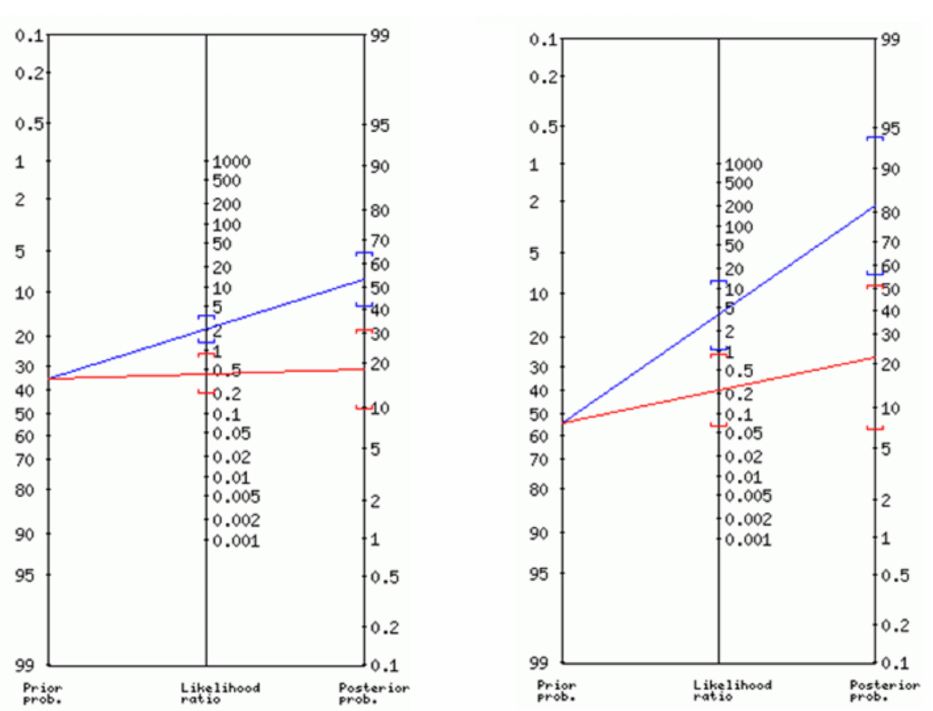
Figure 3. Post-test positive (blue line) and negative (red line) probabilities of malnutrition in can- didates on the waiting list for kidney transplantation ( left ) and in the subgroup of subjects with BMI < 25 kg/m 2 ( right ). Nomograms computed with the ‘Diagnostic Test Calculator’ (available at